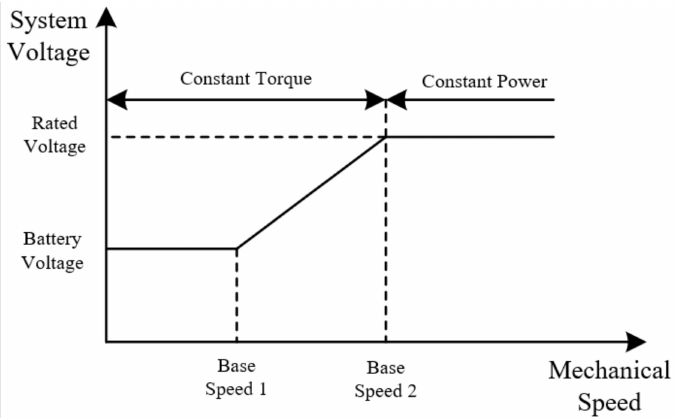
Figure 2. Required system voltage with mechanical speed.